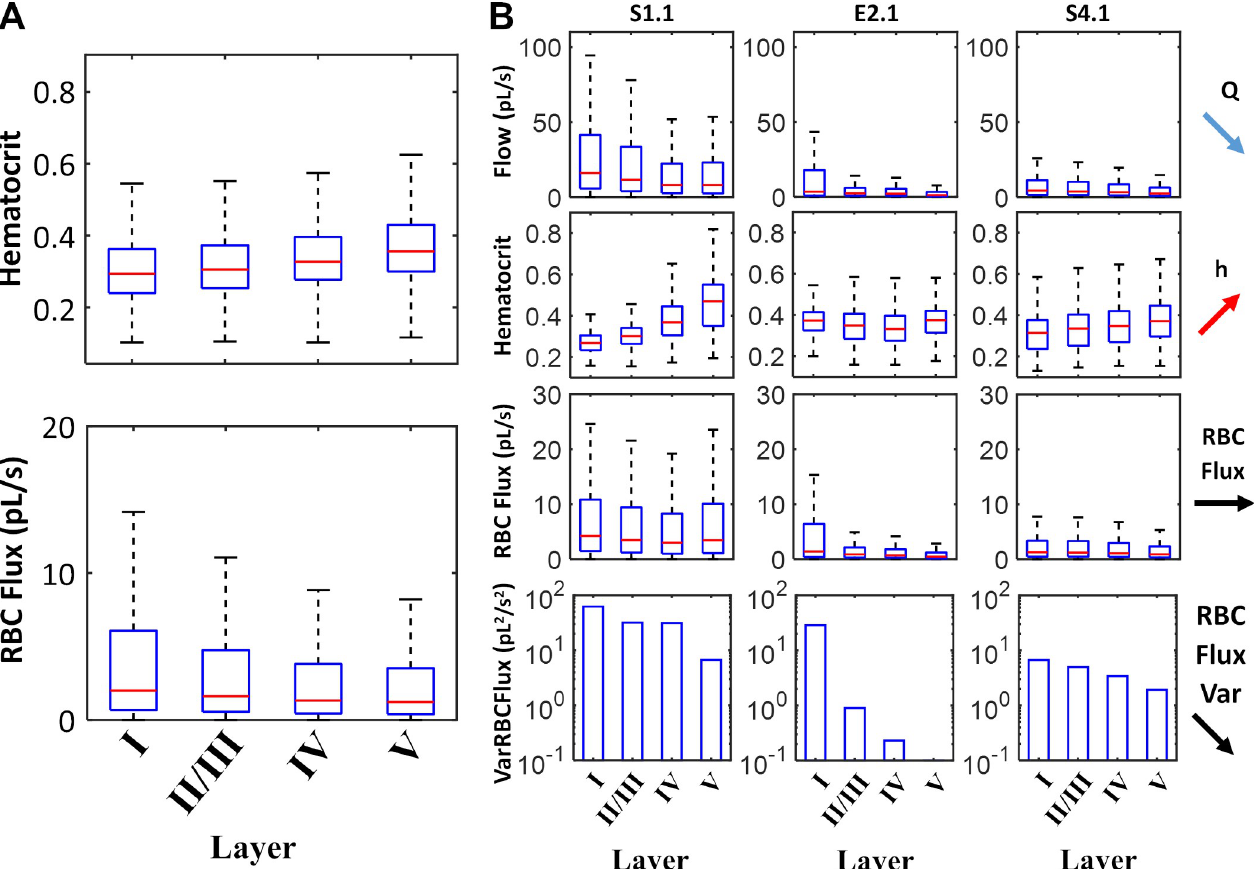
Fig 4. Statistics of hematocrit distribution and RBC fluxes in cortical layers of cerebral microcirculatory networks. (A) Statistics over an ensemble of experimental (N = 4) and synthetic (N = 12) data sets show higher discharge hematocrit in deeper segments (N = 1,234,412 with p < 0.01 using one-way ANOVA). The median (red line), 25-75 th percentile (blue box) and limits (black lines, excluding outliers) of hematocrit in all blood vessels for each layer obtained for all data sets. (B) Statistics in three individual data sets (S1.1, E2.1, S4.1, N = 59830, 94842, and 108833 respectively, p < 0.01 in all cases). In all case, layer V has higher hematocrit levels than the layers closer to the cortical surface. In general, shorter surface paths (layer I) tend to have higher flow rate, Q , but lower hematocrit levels, h . The total red blood cell flux (RBC) is rather uniform for all cortical layers, because the flow effect ( Q , lower in deep layers) and hematocrit ( h , higher in deep layers) balance each other out. The variance of the RBC fluxes, VarRBCFlux , decreases with depth; accordingly there is more homogenous RBC flux distribution in deeper layers.